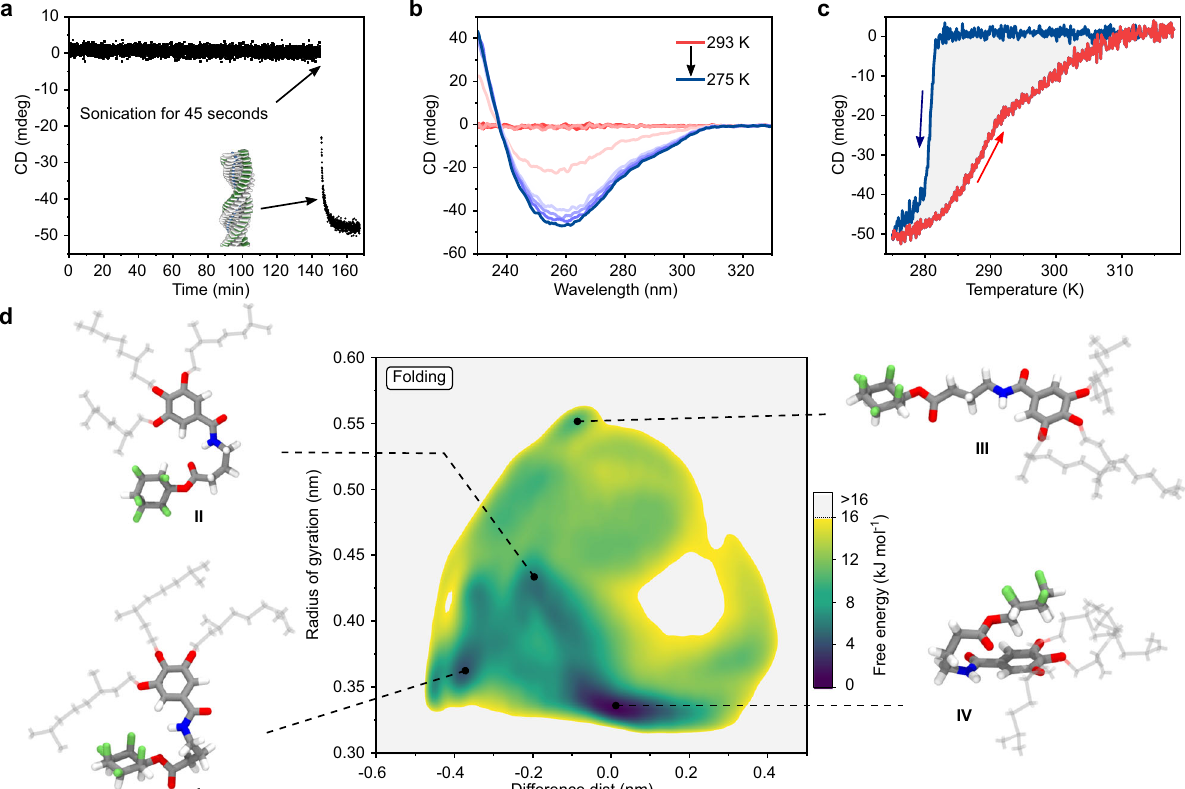
Fig. 3 Studies on monomer folding. a CD monitoring (260 nm) of M 3 (1.2 mM) in cyclohexane/chloroform (84:16 v/v) at 293 K, indicating remarkable kinetic stability. b Temperature-dependent CD spectra of M 3 (1.2 mM) in cyclohexane/chloroform (84:16 v/v) upon cooling from 293 K to 275 K (0.5 K min − 1 ). c CD monitoring (260 nm) of cooling (blue) and heating (red) of a 1.2 mM solution of M 3 in cyclohexane/chloroform (84:16 v/v) at a rate of 0.5 K min − 1 . Once nucleation starts in a concentrated solution at temperatures for which Δ G is already negative, polymerization proceeds very rapidly since the concentration of free monomer in solution is high, leading to a very sharp transition during cooling (blue line). d Free energy surface (FES) estimated from WT-MetaD simulations, showing monomer conformations and their relative free energies as a function of collective variables CV1 ( x -axis: difference between the distance between penta fl uorocyclohexyl-Hs and the amide oxygen and the distance between the penta fl uorocyclohexyl-Fs and the amide nitrogen) and CV2 ( y -axis: radius of gyration of M 3 monomer core). Blue colored areas represent the low free energy domains while the gray colored background is high in free energy or not accessible. Four representative monomer conformations (I, II, III, IV) taken from the FES are reported (alkyl chains are shown in transparency for clarity). Color code: green: F; red: O; blue: N; gray: C. (84:16 v/v, standard solvent) because time-dependent CD mea- Slow cooling (0.5 K min − 1 ) of a 1.2 mM solution of M 3 resulted surements of a 1.2 mM solution of M 3 at 293K, revealed that in in a pronounced negative Cotton effect with an absorption this medium, M 3 is remarkably kinetically persistent and remains maximum at 260 nm, indicating the formation of chiral supra- molecular aggregates (Fig. 3b). The transition from the dissolved molecularly dissolved for hours. However, ultrasonication for 45 s to the polymerized state occurs abruptly with an elongation induces polymerization (Fig. 3a), forming a clear viscous solution. NATURE COMMUNICATIONS| (2021) 12:3134